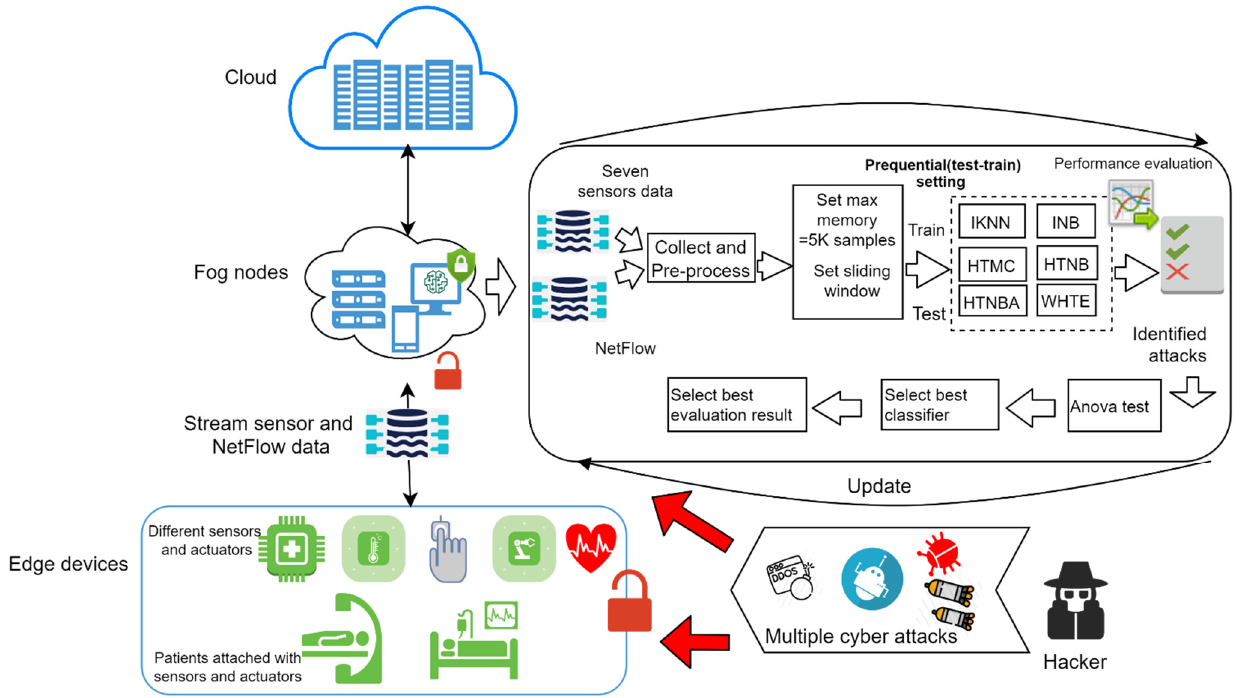
Figure 2. The framework of the proposed hybrid attack detection system.